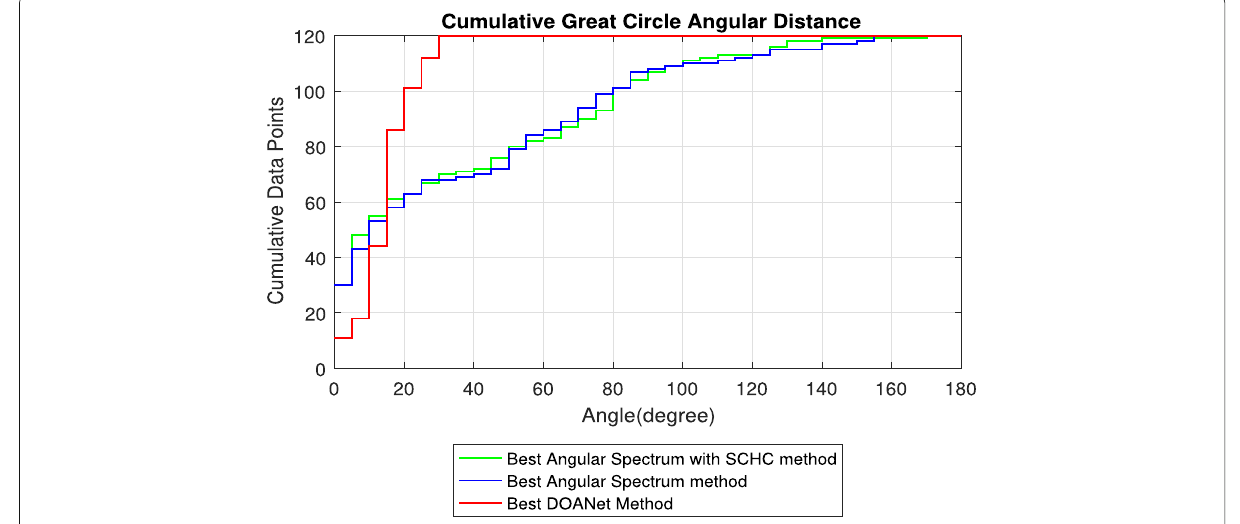
Fig. 10 AUCs for cumulative static great-circle angular